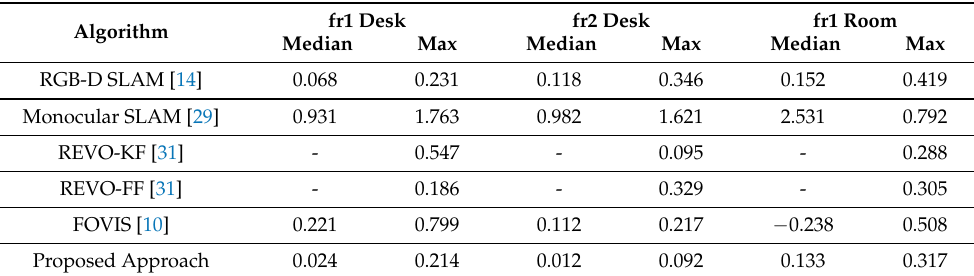
Table 3. Comparison of median/maximum values of ATE with state-of-the-art